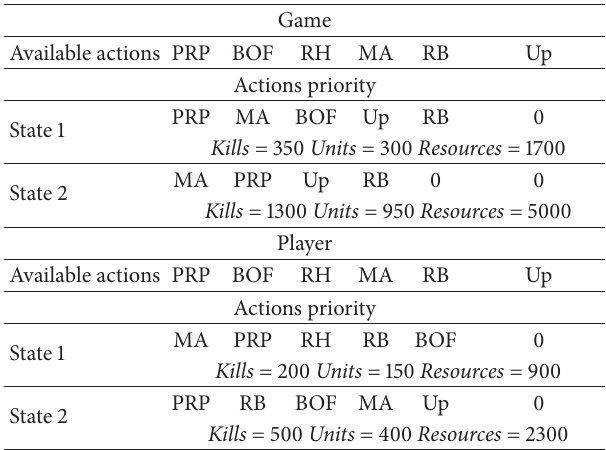
Table 5: LSCAPI tower of souls case.